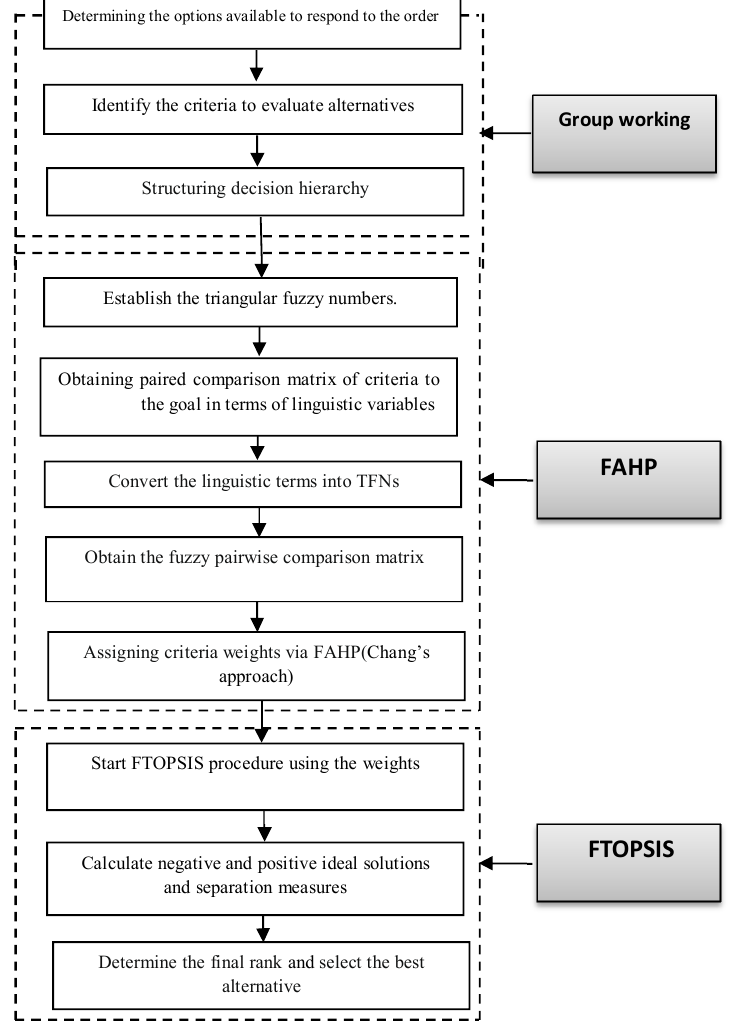
Fig.2. Schematic diagram of the proposed